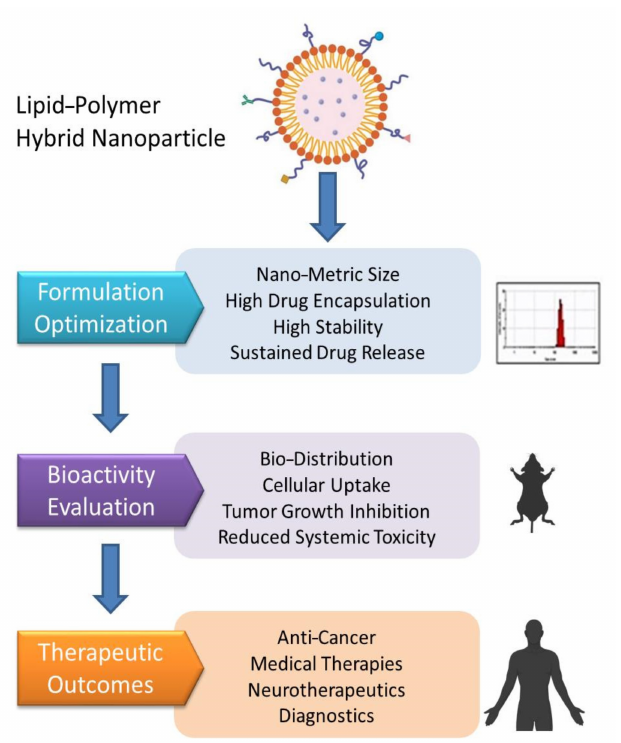
Figure 9. Hierarchy of the steps involved in the translation of PLNs in